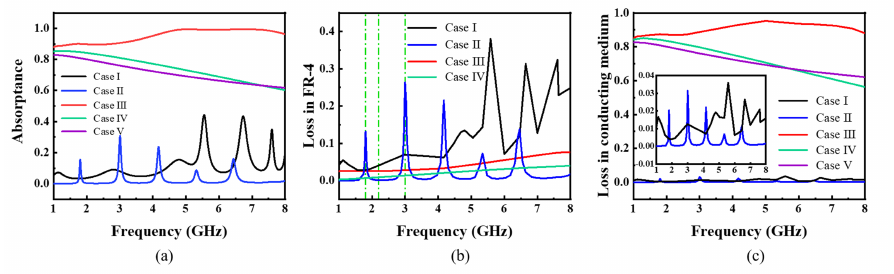
Figure 7. ( a ) The absorptance of five cases. Power loss in material. ( b ) in FR-4. ( c ) in conducting